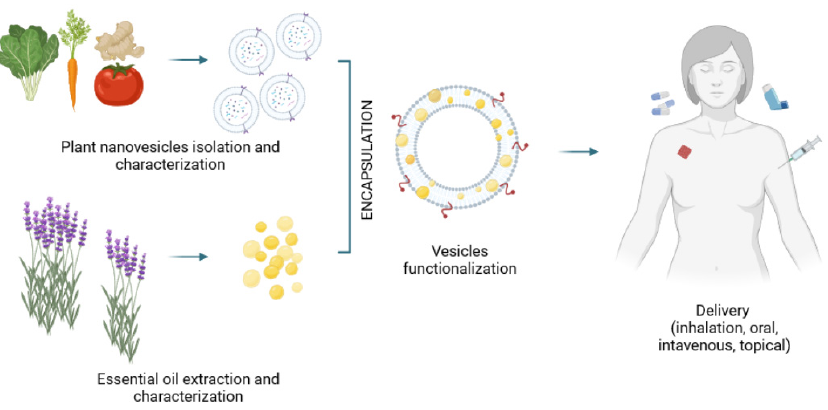
Figure 2. Plant-derived nanovesicles for essential oil delivery: a work-flow proposal.